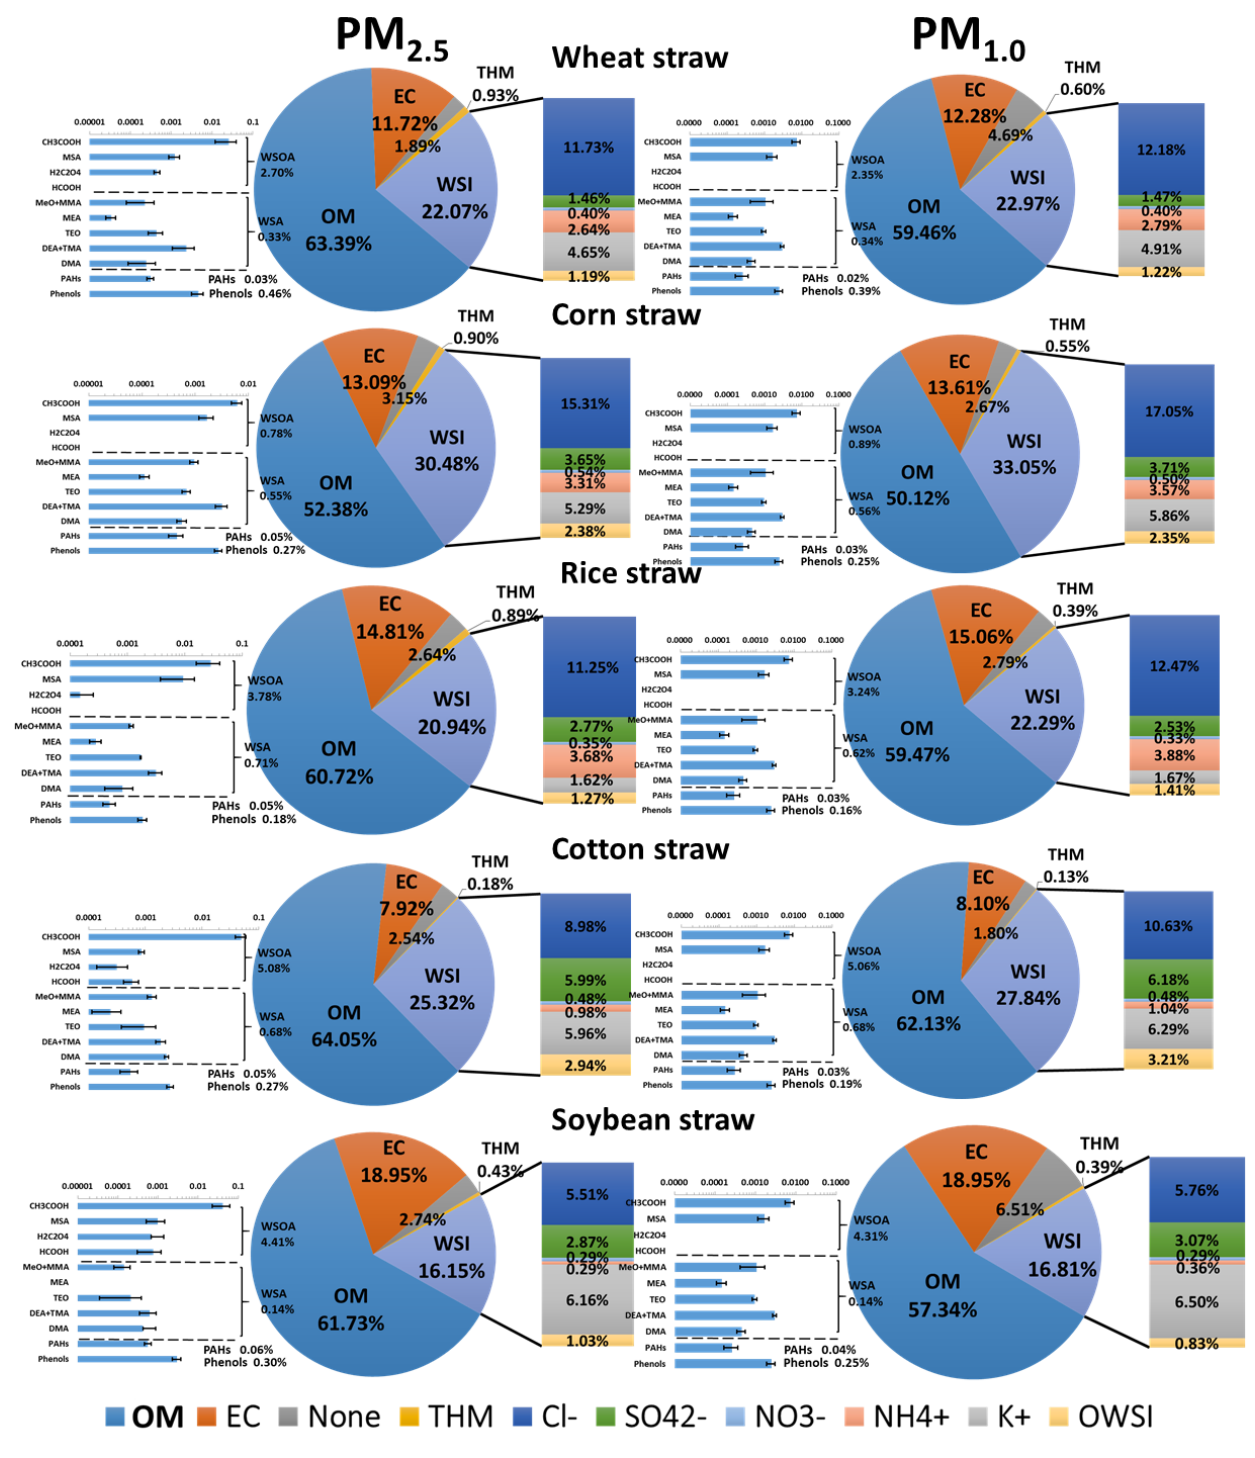
Figure 2. Chemical profiles of smoke PM 2 . 5 and PM 1 . 0 from five types of agricultural residue burning. OM (organic matter) is 1.3 × OC. OWSI: other water-soluble ions, including F − , NO − , Na + , Ca 2 + , Mg 2 + 2